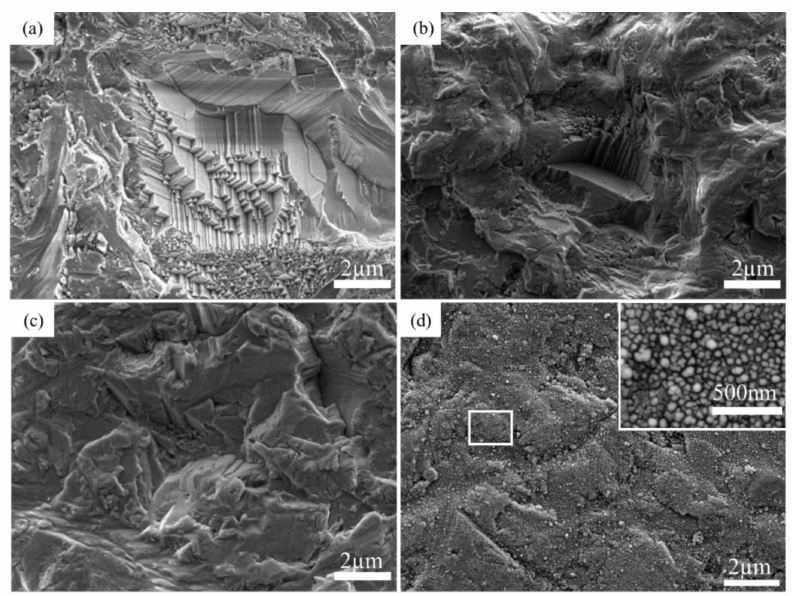
Figure 2. Topography of the substrate in electroless plating pretreatment after ( a ) grinding, ( b ) etching, ( c ) activation and ( d ) initial plating.